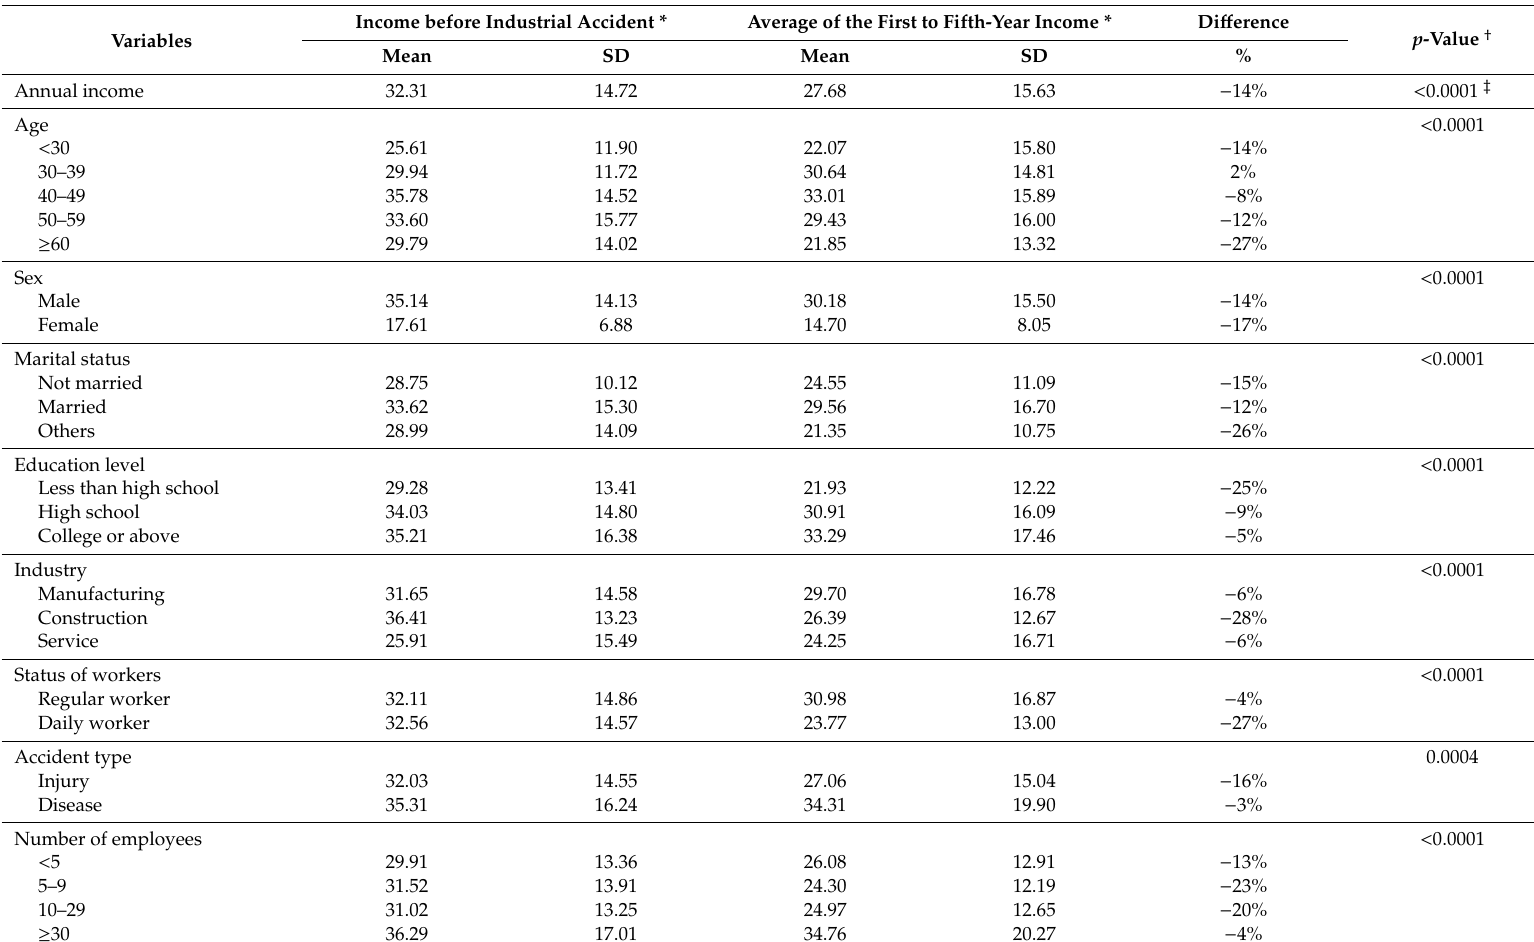
Table 3. Comparison of the income before industrial accident and the five-year average income after the industrial accident according to general characteristics (unit: million